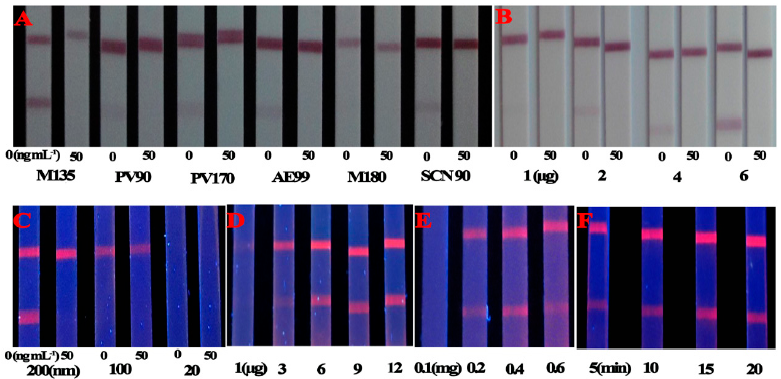
Figure 2. LFIA optimization. ( A ) Different NC membranes; ( B ) Amount of MAb for conjugation with CG; ( C ) FMs diameter; ( D ) Amount MAb loaded onto FMs; ( E ) Amounts of EDC; ( F ) Incubation time.